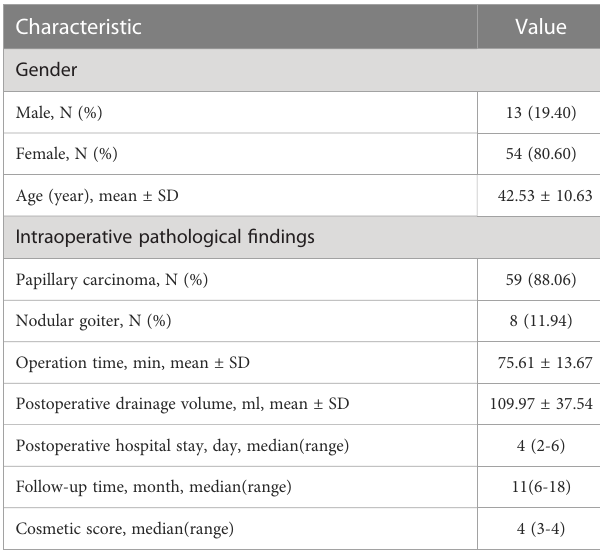
TABLE 1 Basic information of